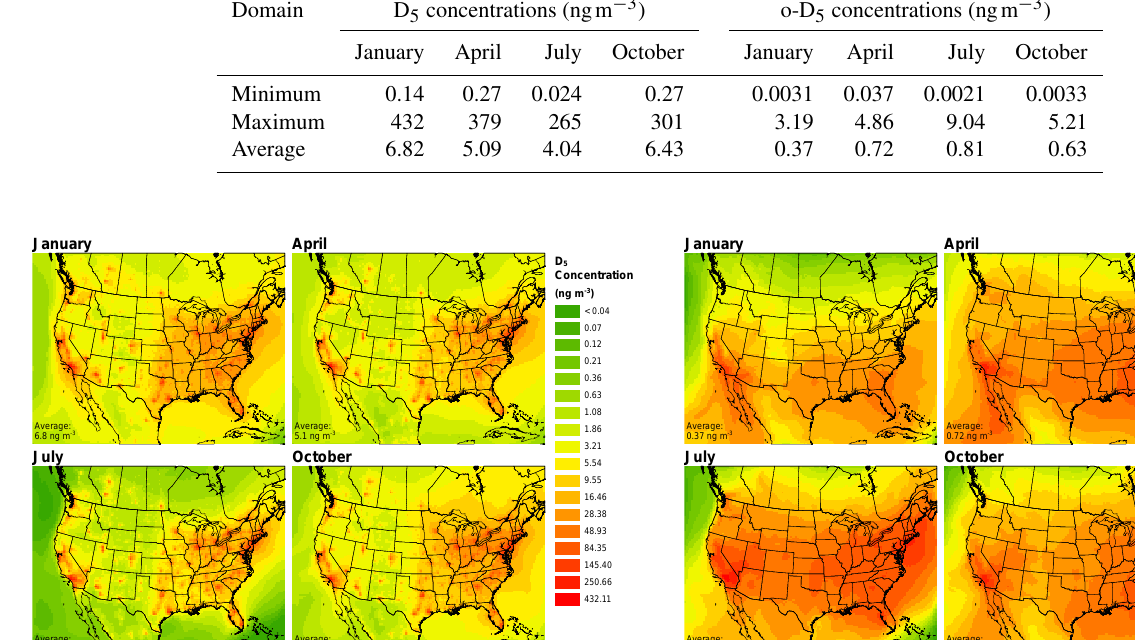
Table 1. Monthly minimum, maximum, and average D 5 and o-D 5 concentrations in the lowest modeled layer for the domain. Domain